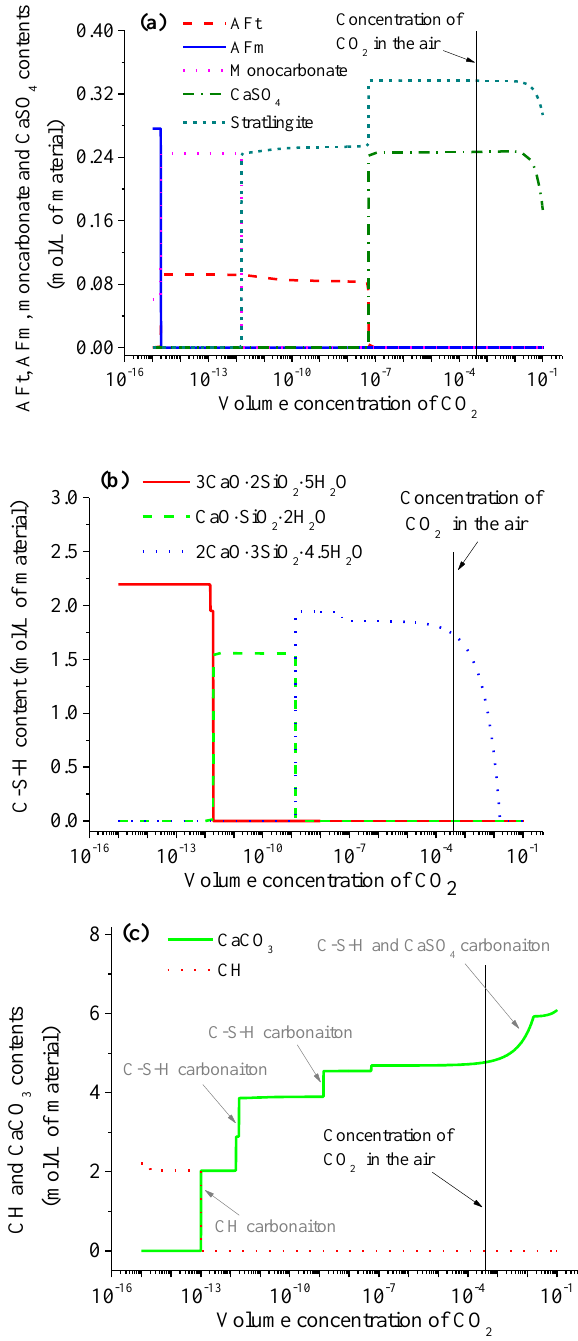
Figure 2. Phase assemblages of the hardened cement paste in a completely carbonated mortar as a function of the CO 2 concentrations: ( a ) AFt, AFm, monocarbonate and CaSO 4 phases; ( b ) C-S-H phases with different Ca/Si ratios; ( c ) CH and CaCO 3 phases.